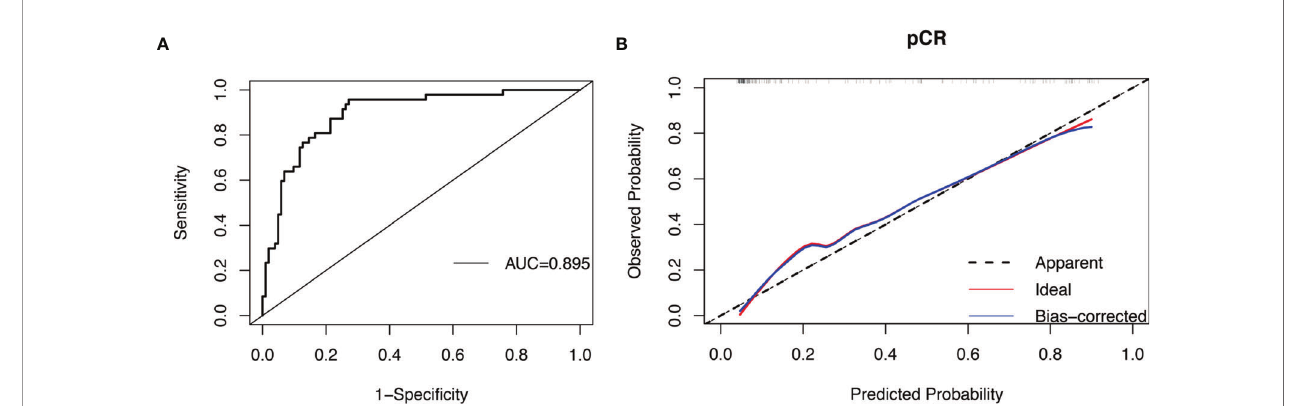
FIGURE 3 | ROC curve and calibration curve of BCNACT pCR prediction model: (A) ROC curve. (B) calibration